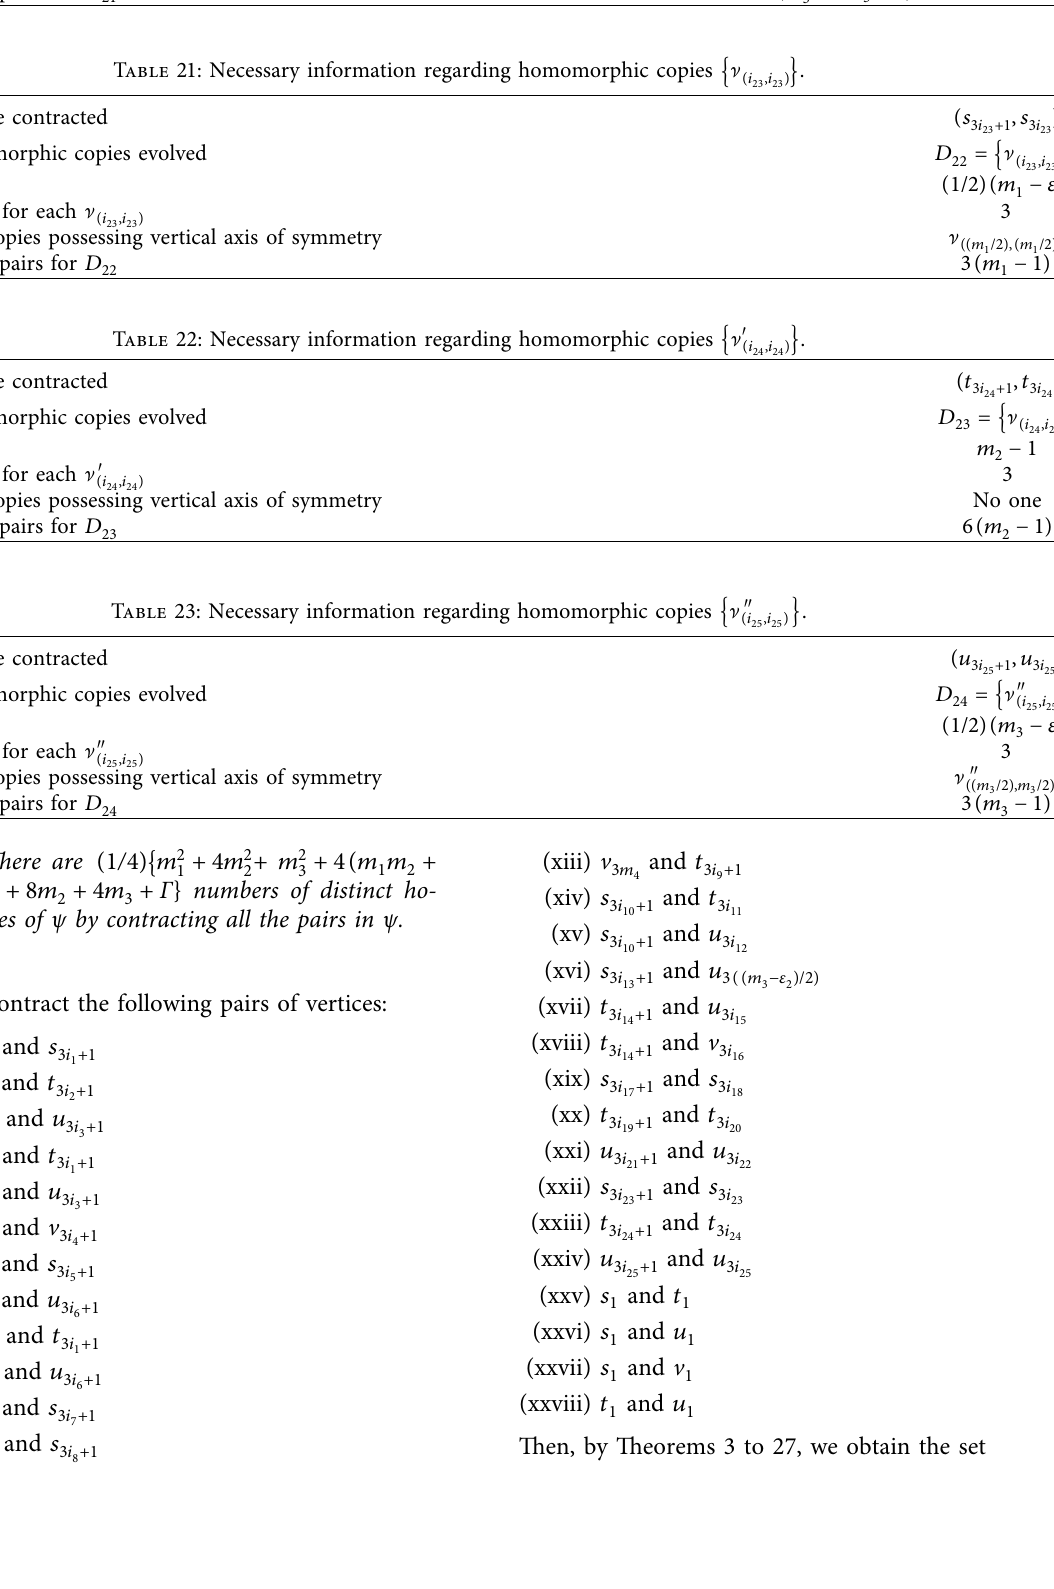
Table 21: Necessary information regarding homomorphic copies ]